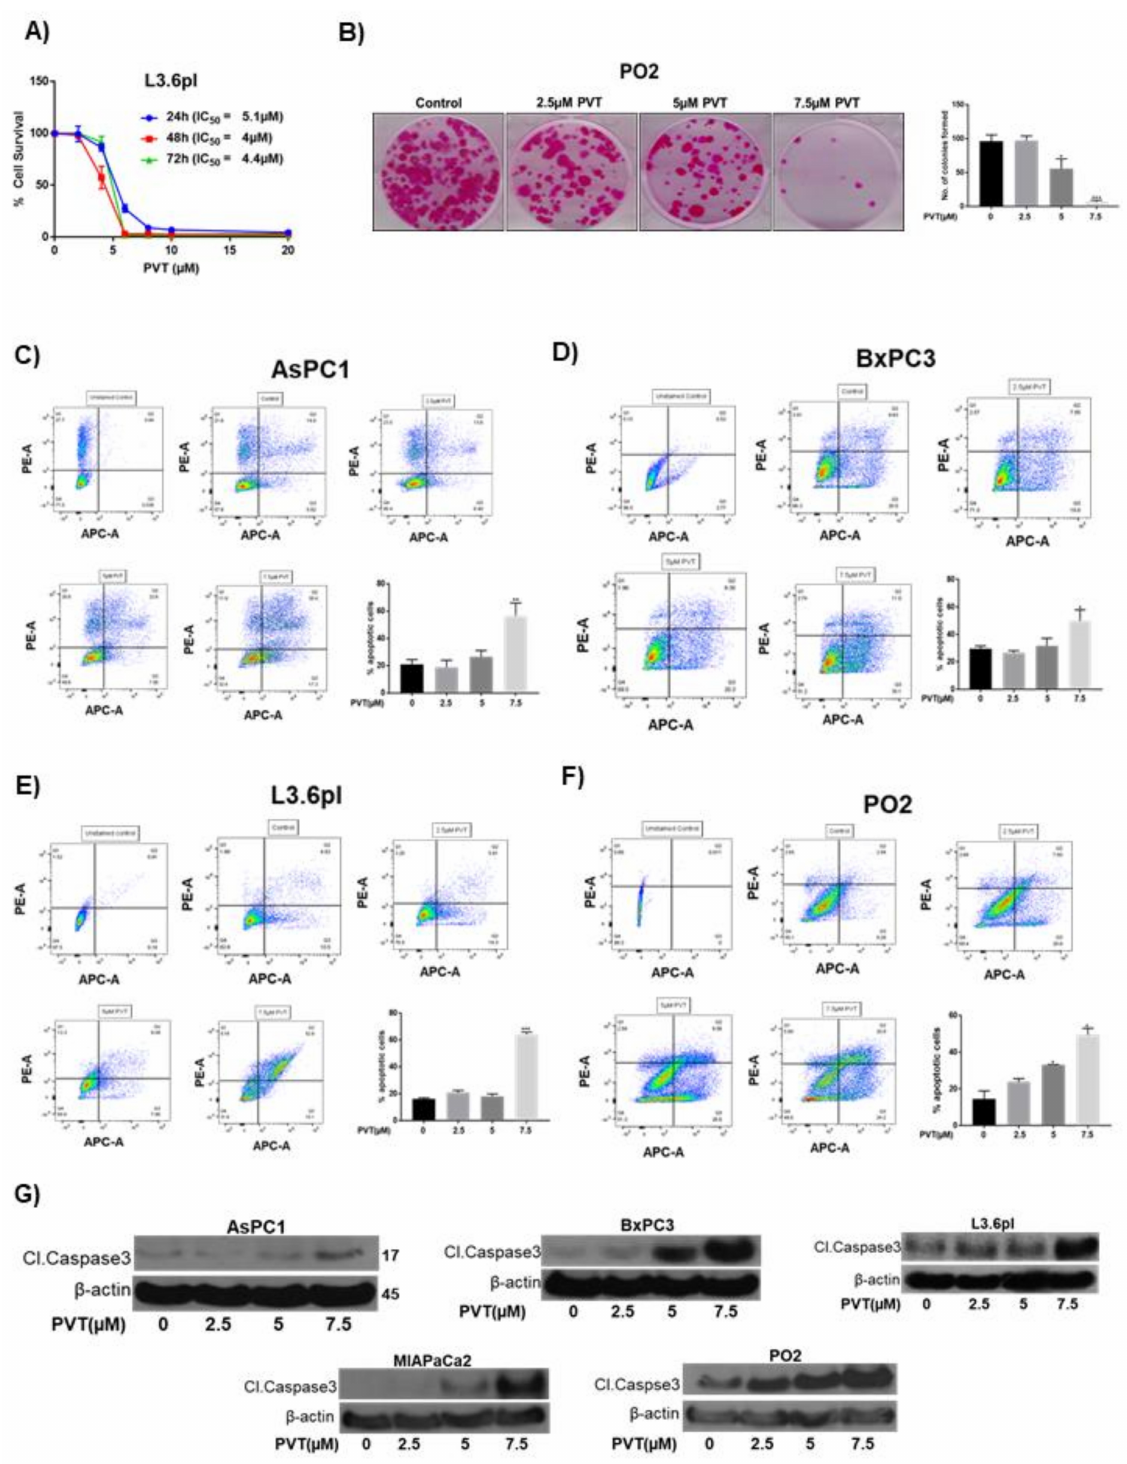
Figure 7. Anti-proliferative and apoptotic effects of PVT in PDAC cells ( A ) Cytotoxic effects of PVT were evaluated in L3.6pl cells by SRB assay. ( B ) Colony formation assay on PO2 cells. ( C ) AsPC1 ( D ) BxPC3 ( E ) L3.6pl and ( F ) PO2 cells were evaluated by AnnexinV/APC assay. Early- and late-stage apoptosis was added and plotted in graphs. Data were quantitated using FlowJo software and plotted using GraphPad Prism 7.0. Whole cell lysates of ( G ) AsPC1, BxPC3, L3.6pl, MIAPaCa2, and PO2 cells treated with increasing concentrations of PVT were immunoblotted for cleaved caspase 3. Statistically significant when compared with control. * p ≤ 0.05, ** p ≤ 0.01, *** p ≤